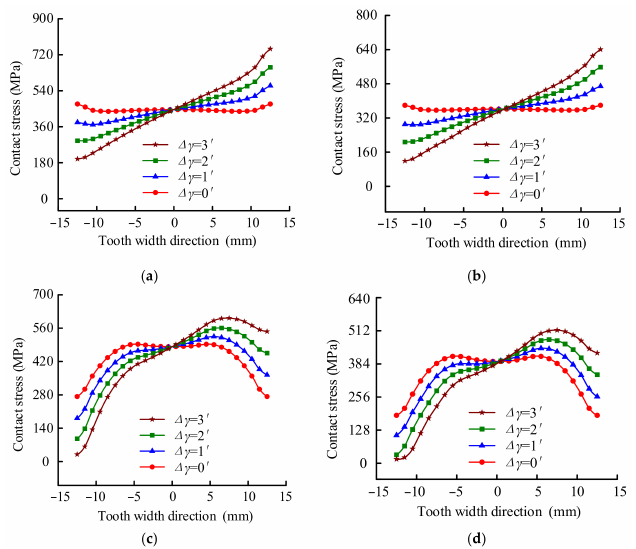
Figure 17. Comparison of tooth surface load distribution between novel gears and involute gears with different misalignment errors. ( a ) Unmodified involute gears; ( b ) Unmodified novel gears; ( c ) Modified involute gears; ( d ) Modified novel